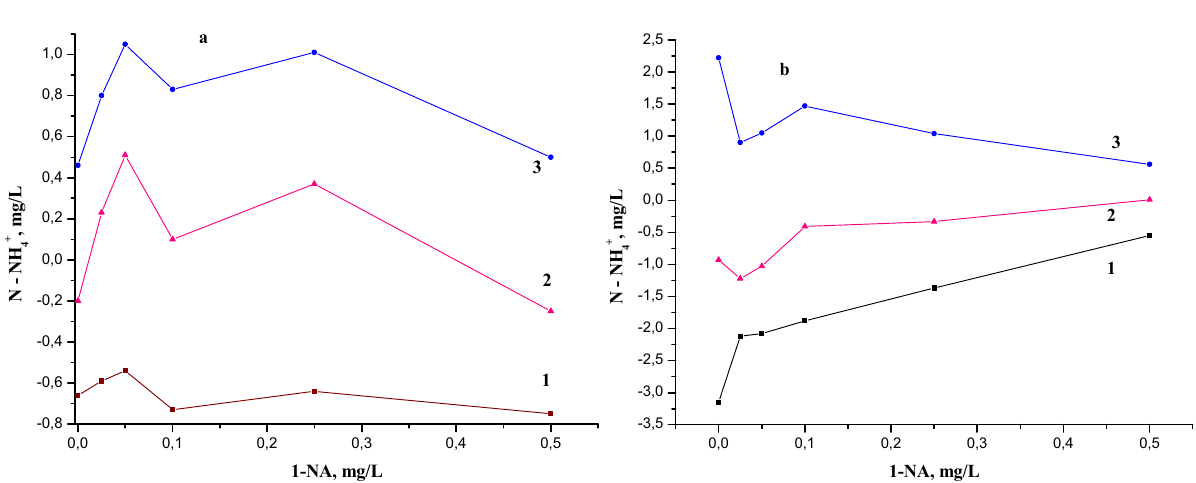
Figure 3. ( a ) The following differences of ammonium ion concentrations: (1) (C1-C0); (2) (C2-C0); (3) (C2- C1) in function of 1-NA concentration with initial 3 mg/L NH 4 + . ( b ) The same functions with initial 6 mg/L NH 4+